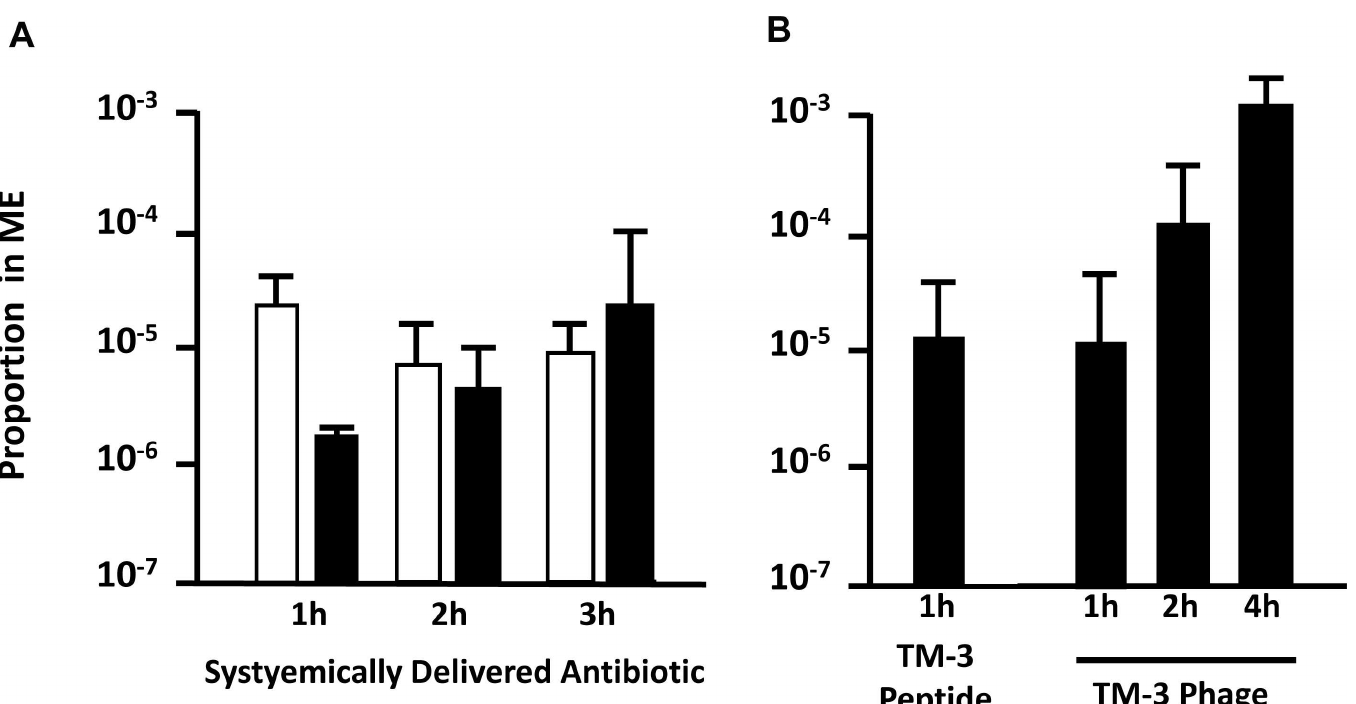
Fig 4. Comparison of peptide phage transport to systemic antibiotic delivery in the ME. A. Proportionof systemically deliveredantibiotics that were observedin the ME of patients at 1, 2 or 3 hrs after systemic administration by Silverstein et al. [43] (penicillin,500,000units; black bars) or Nicolauet al. [44] (cefprozil, 15 mg/kg; white bars). B. Proportionof TM-3 peptidephage,appliedto the TM, that was recovered from the ME 1, 2 or 4 hrs later, and TM-3 peptide, appliedto the TM, recoveredfrom the ME 1 hr later. Error bars = SEM (n = 4).